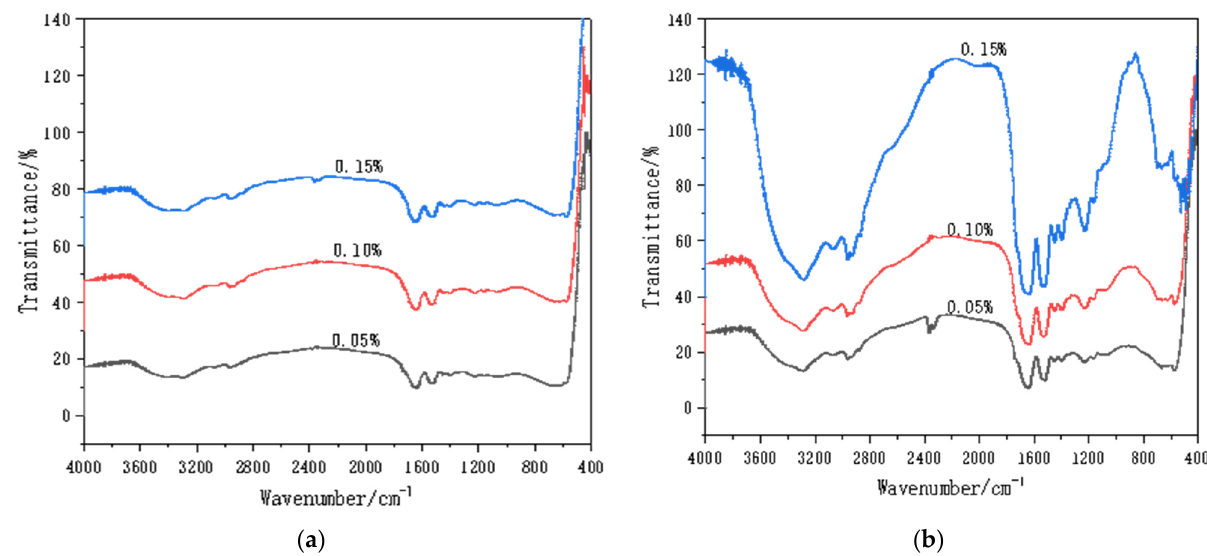
Figure 5. FTIR of WPI fibril–CNTs (or CNOs) (the concentrations of CNTs or CNOs were 0.05 wt.%, 0.1 wt.%, and 0.15